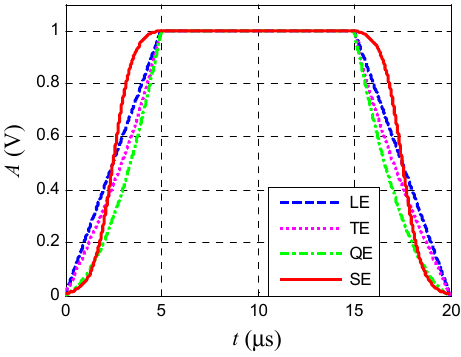
Figure 3. The four types of pulse envelopes used in this study.